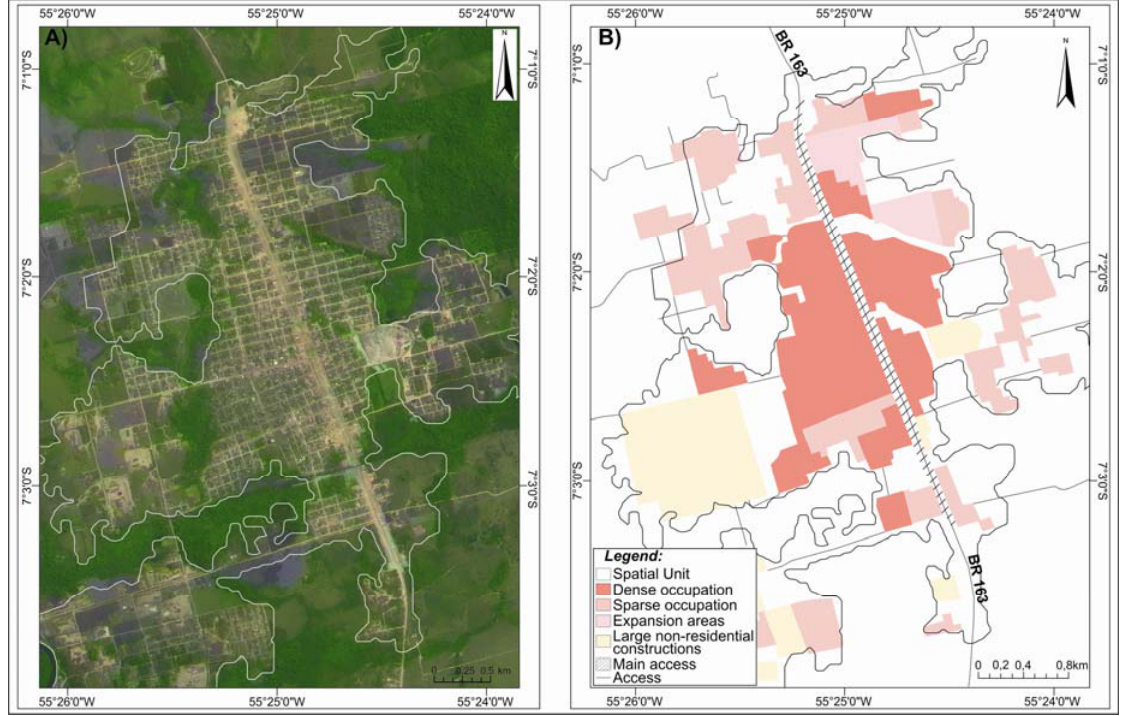
Figure 4. Boundaries of the spatial unit of human occupation obtained from Landsat TM for